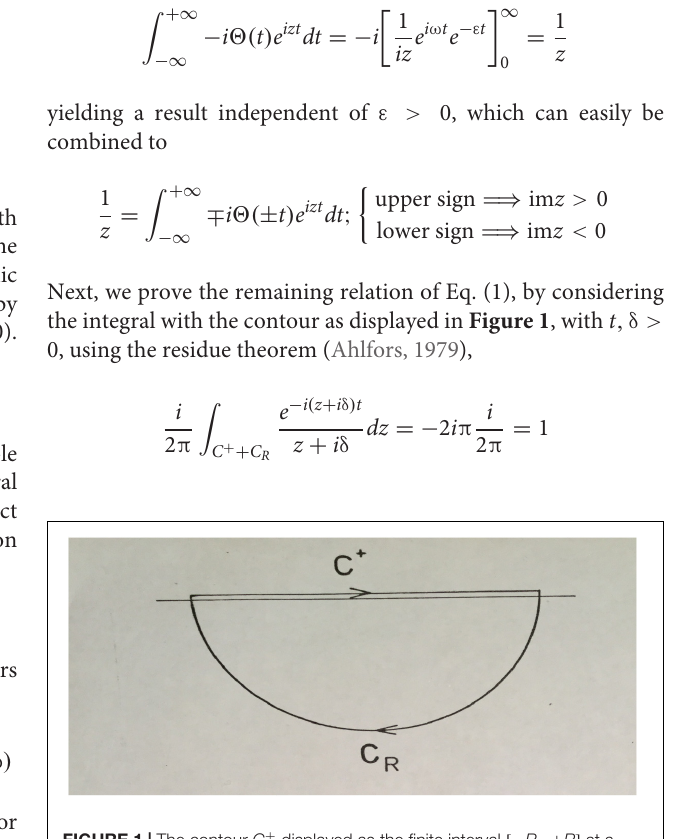
FIGURE 1 | The contour C + displayed as the finite interval [− R , + R ] at a finite distance ε above the real axis. By closing the half circle C R , with radius R , in the lower half of the complex plane, the integral can be simply evaluated as the sum of residues of the poles of the actual function inside C + + C R